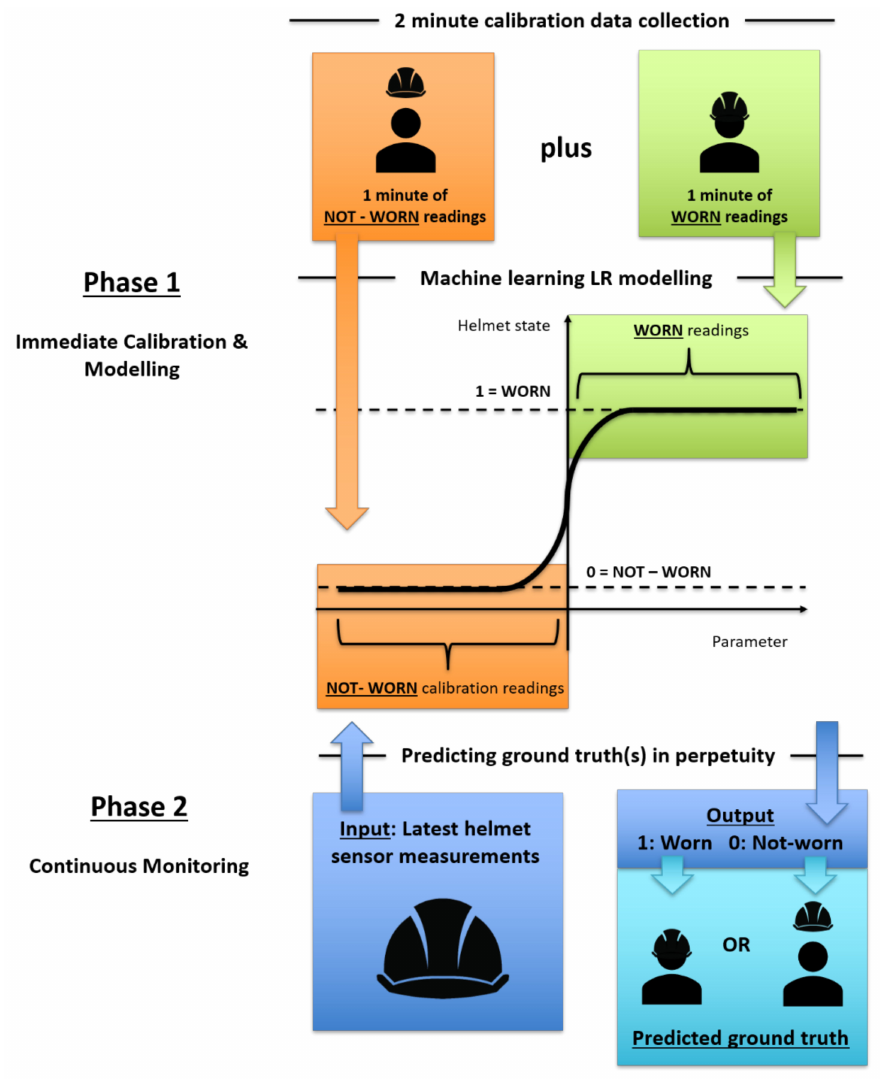
Figure 1. Schematic of machine learning logistic algorithm for helmet wearing determination.